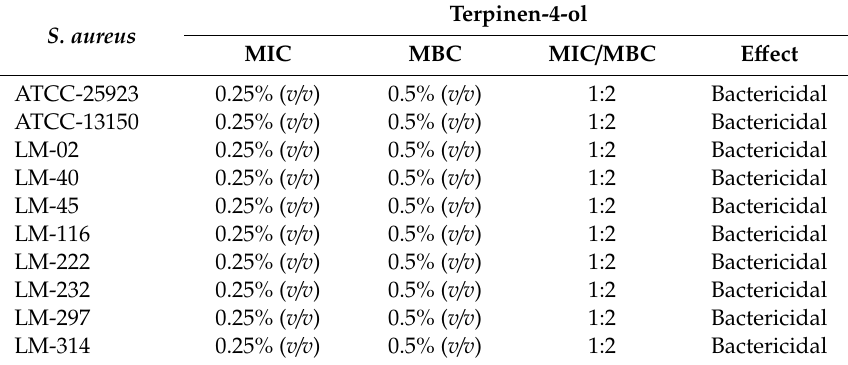
Table 1. Minimal Inhibitory Concentration (MIC), Minimal Bactericidal Concentration (MBC), and classification of the e ff ect of terpinen-4-ol against Staphylococcus aureus strains. S.